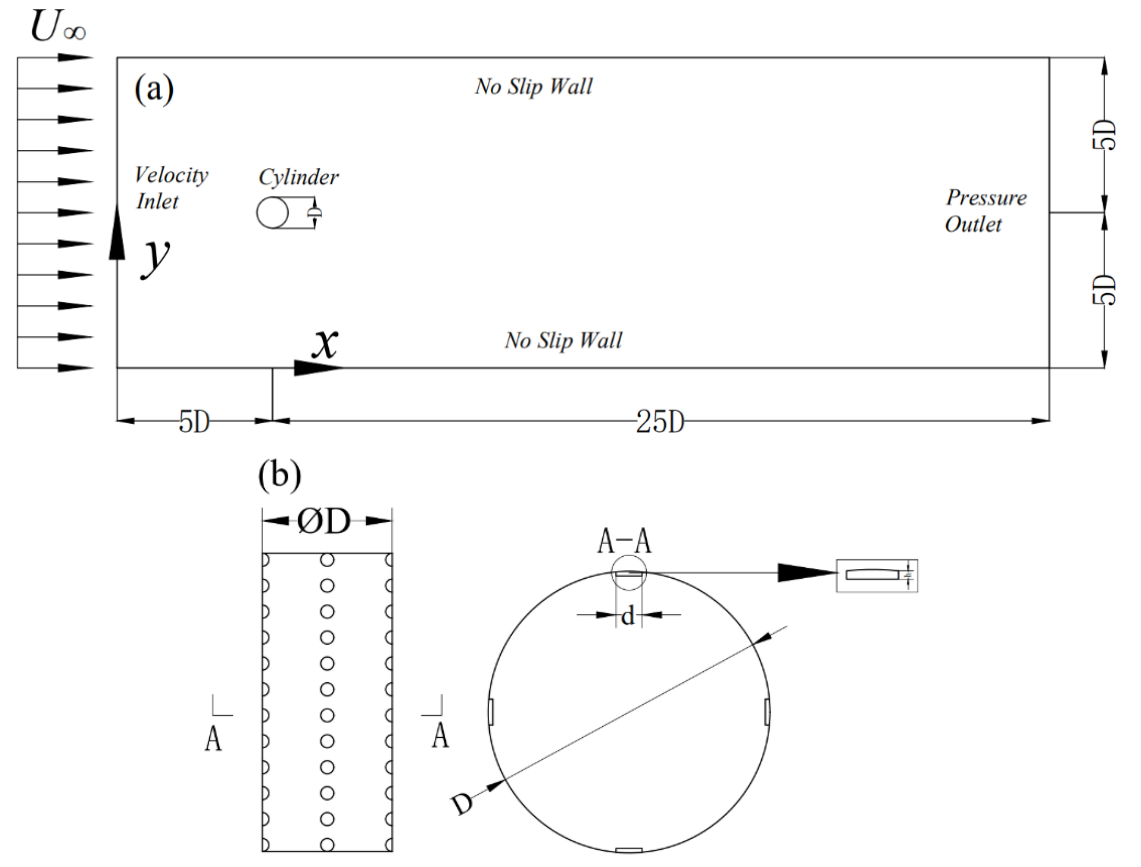
Figure 1. The schematic diagrams of the computational domain and the cylinder: ( a ) Computational domain; ( b ) The distribution of four columns of dimples on the surface of the cylinder.